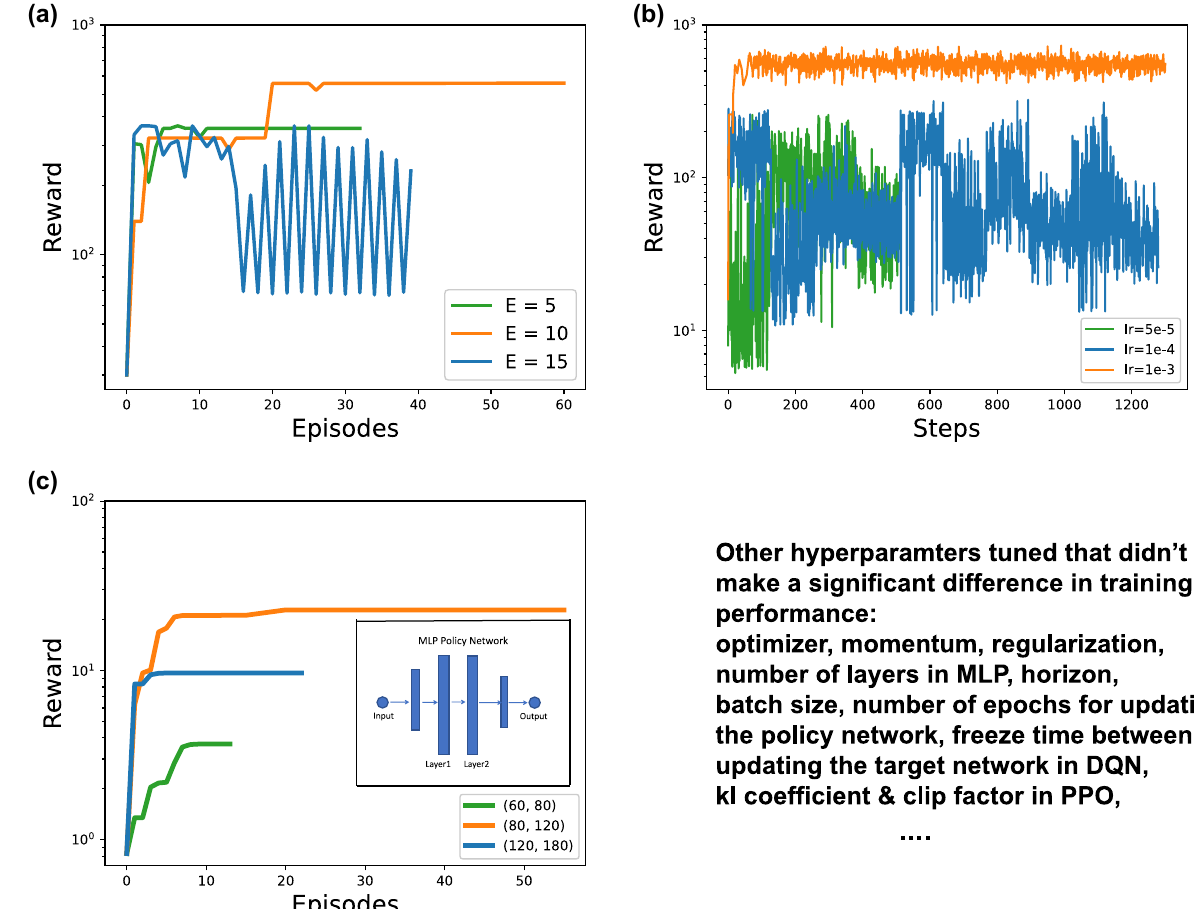
Figure 6: Comparative studies on tuning key hyperparameters in the process of finding the optimal settings for L2DO(-DSA). (a) Learning curves for different E values (i.e., 5, 10, and 15) set in the L2DO-DSA framework with PPO. The curve that reached the maximum converged reward in the shortest time possible has the optimal E we are looking for. (b) Learning curves for different learning rates lr (i.e., 5e − 5, 1e − 4, and 1e − 3) set in L2DO-DSA with PPO for updating the policy network. Rewards versus steps is plotted in this case to more closely examine the effects of different lr’s . (c) Learning curves for different numbers of neurons in the middle 2 layers of the MLP policy network set in L2DO with DQN. Three combinations are chosen: (60, 80), (80, 120), and (120, 180). Inset: middle 2 layers of the policy network. Lower right corner lists some additional hyperparameters tuned by us that did not lead to a significant improvement in